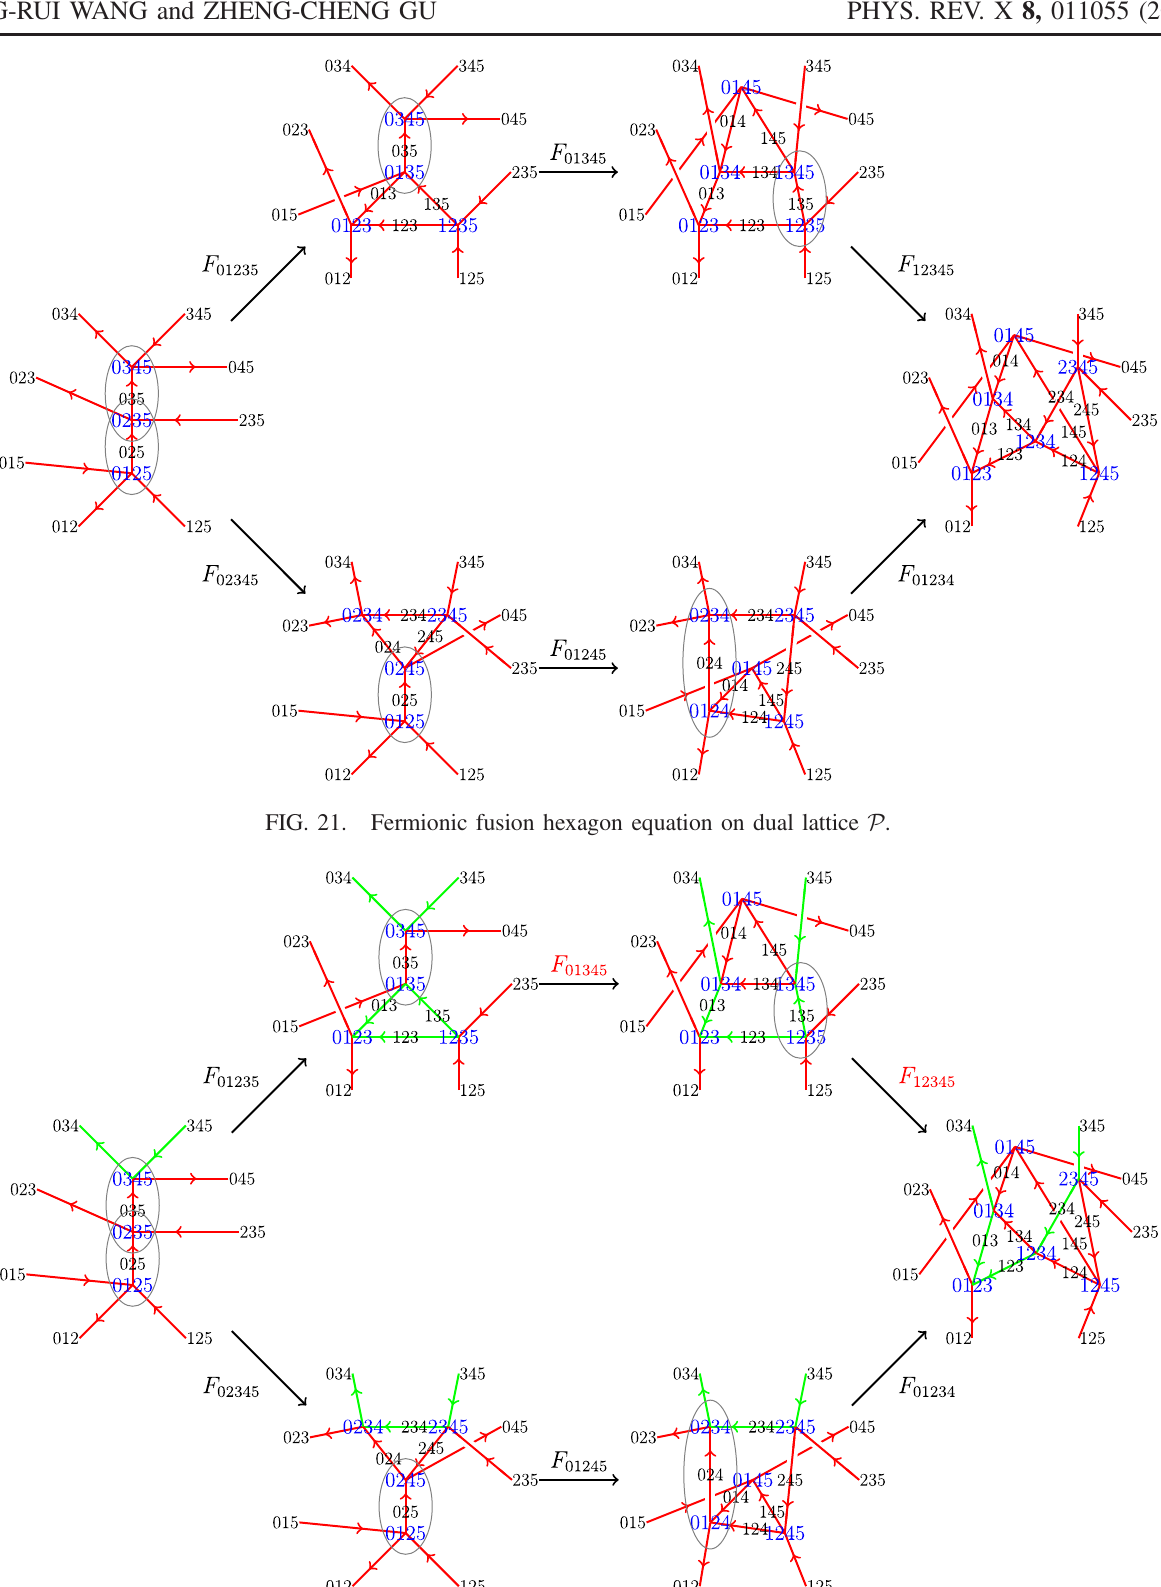
FIG. 22. One example of Kitaev ’ s Majorana chain decoration configuration of fermionic fusion hexagon equation. Green lines indicate that these dual links are decorated by Kitaev ’ s Majorana chains. Among the six F moves for this configuration, only F 01345 and F 12345 (red color in the figure) change the Majorana fermion parity. Therefore, this choice of ˜ n 2 ð g Table III and has obstruction O γ ¼ i